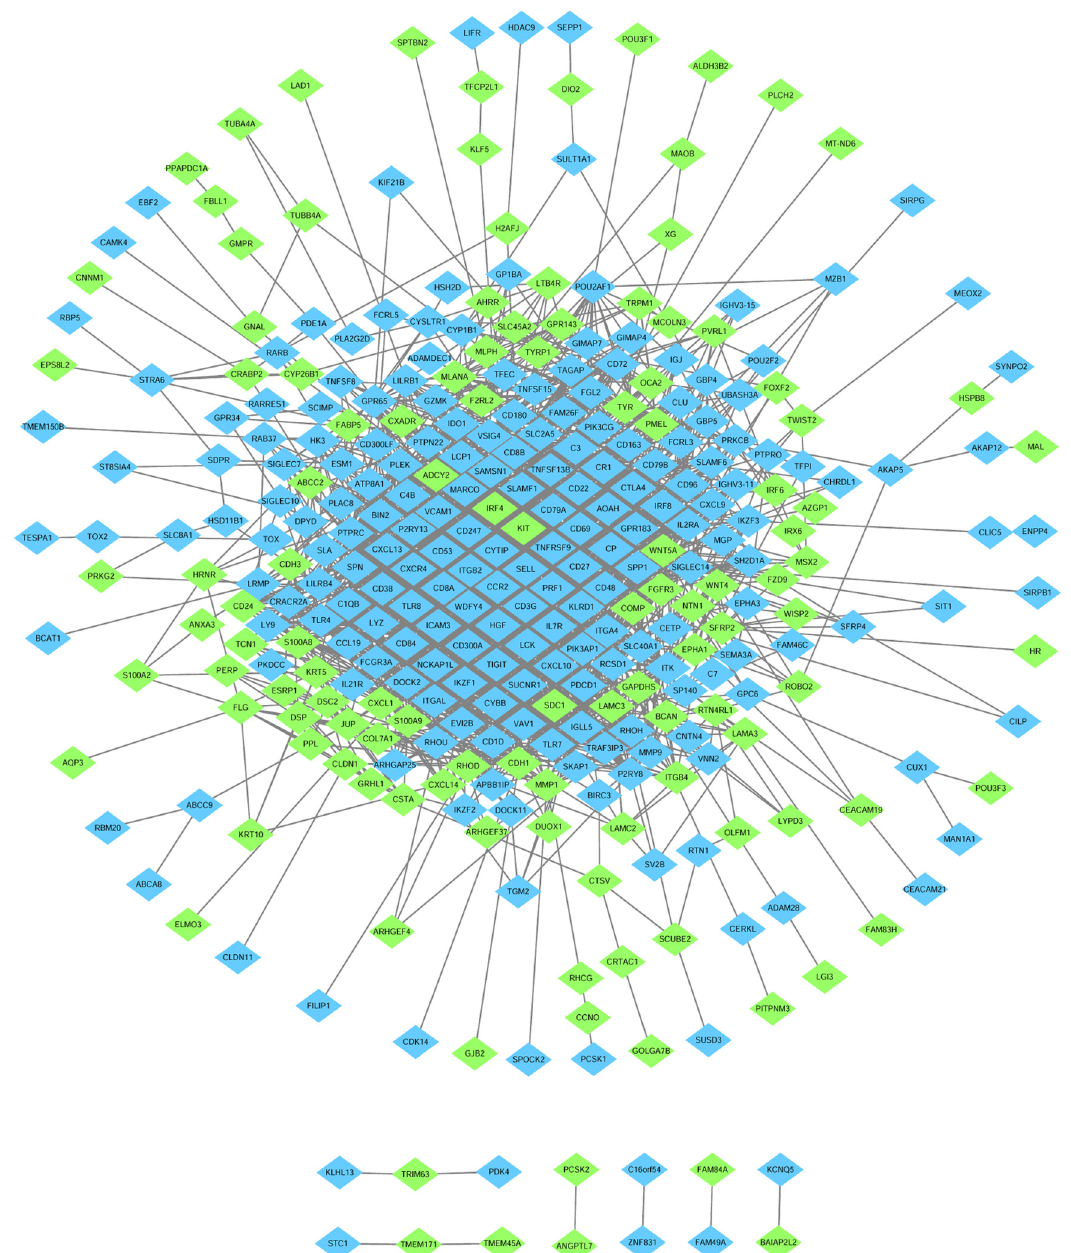
Figure 3: The protein – protein interaction network of DEGs. The nodes represent proteins that correspond to the DEGs. Upregulated DEGs are represented in blue, while downregulated DEGs are represented in green. The proteins connected by edges interact with each